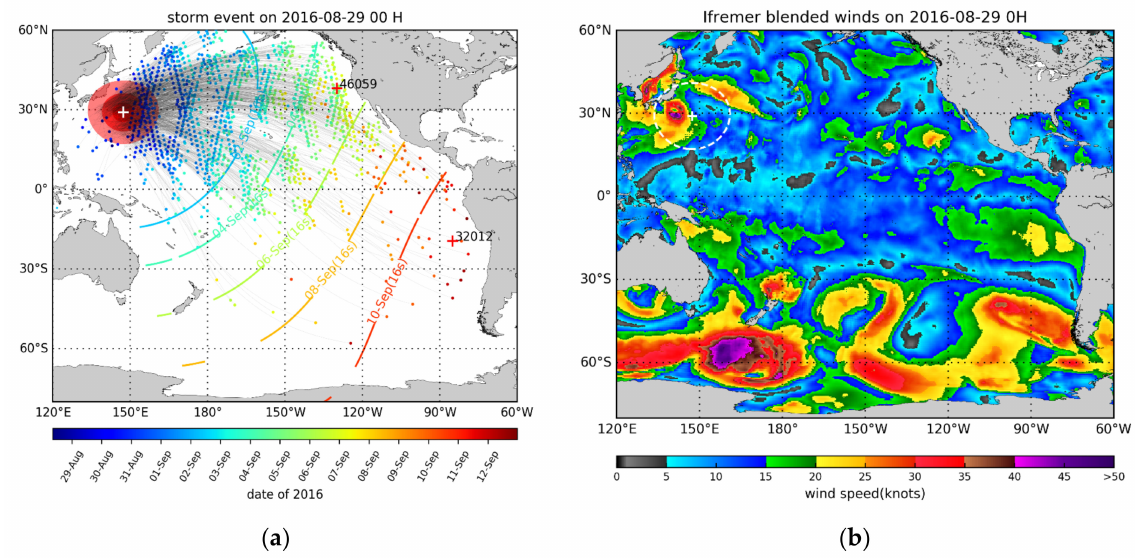
Figure 4. As in Figure 3, but for the case of a swell event originated from Typhoon Lionrock on 29 August 2016 00:00 UTC, centered at 29.0 ◦ S/147.31 ◦ E. ( a ) Illustration of “fireworks” analysis. ( b ) Ifremer blended